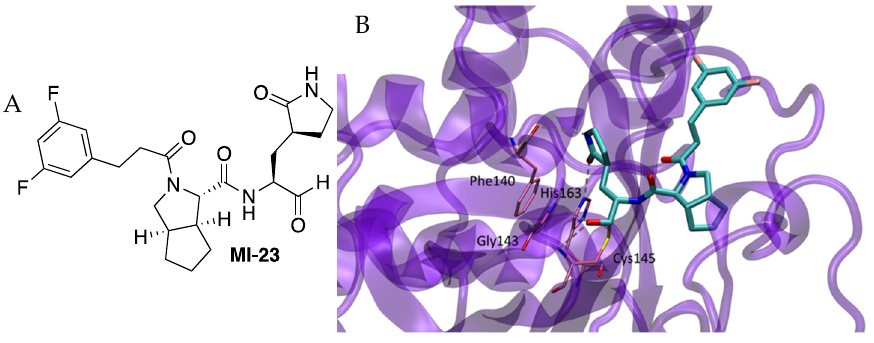
Figure 5. ( A ) Chemical structure of Inhibitor MI ‐ 23 . ( B ) Detail of x ‐ ray structure.